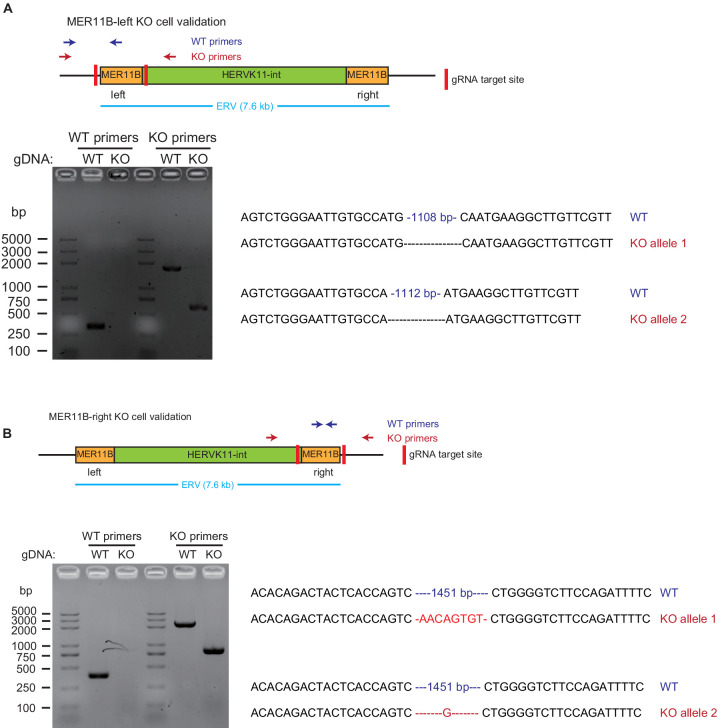
Validation of MER11B-left KO cells and MER11B-right KO cells.For each panel, the upper part is a schematic illustration of the KO design, the lower left is the gel image of PCR validation, and the lower right is the sequences of WT and KO alleles. Panel A is for MER11B-left KO cells, and panel B is for MER11B-right KO cells.